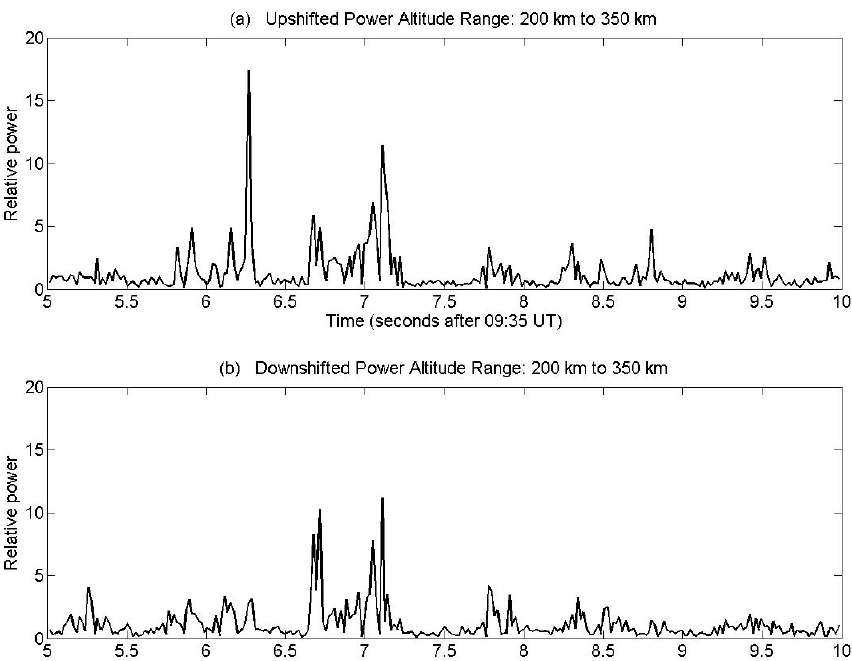
Fig. 7. The relative power, in arbitrary units, from Fig. 6, summed over altitude, (200 to 350km), shown as a function of time for the two frequency ranges. Panel (a) is the up-shifted power (2 to 7kHz) and (b) is the downshifted power ( − 7 to −